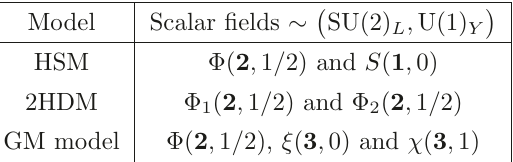
Table 1 . Electroweak quantum numbers of the scalar fields in the non-minimal Higgs sectors